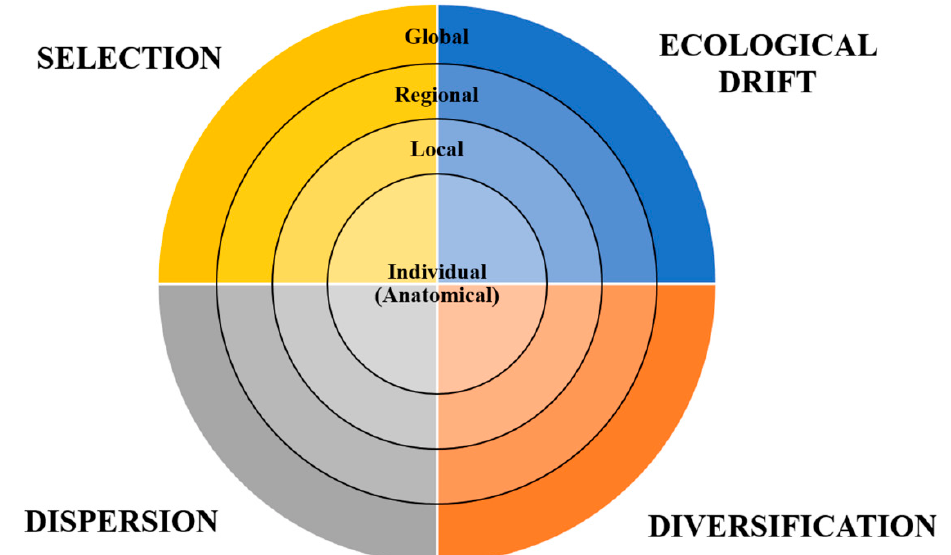
Figure Figure 1. Synthesis of interdependent ecological factors which explain patterns of microbial biogeography across a variety of spatial scales, as proposed by Vellend’s Conceptual Synthesis in Community Ecology (2010) [22]. We included a fourth dimension—that of individual anatomy, to demonstrate that specific biogeographical patterns occur even on a tissue and cellular level.